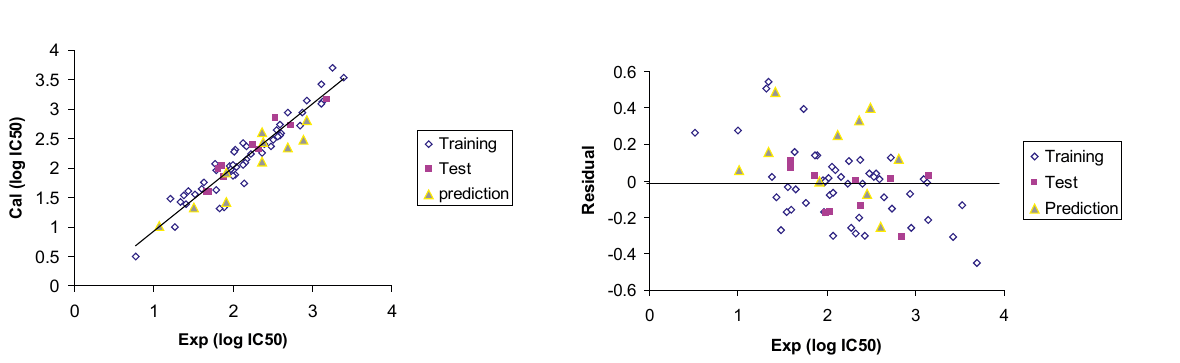
versus residual plot 50